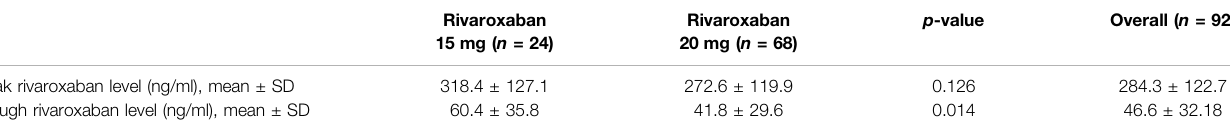
TABLE 2 | Peak and trough rivaroxaban level in patients receiving different dosage of rivaroxaban.